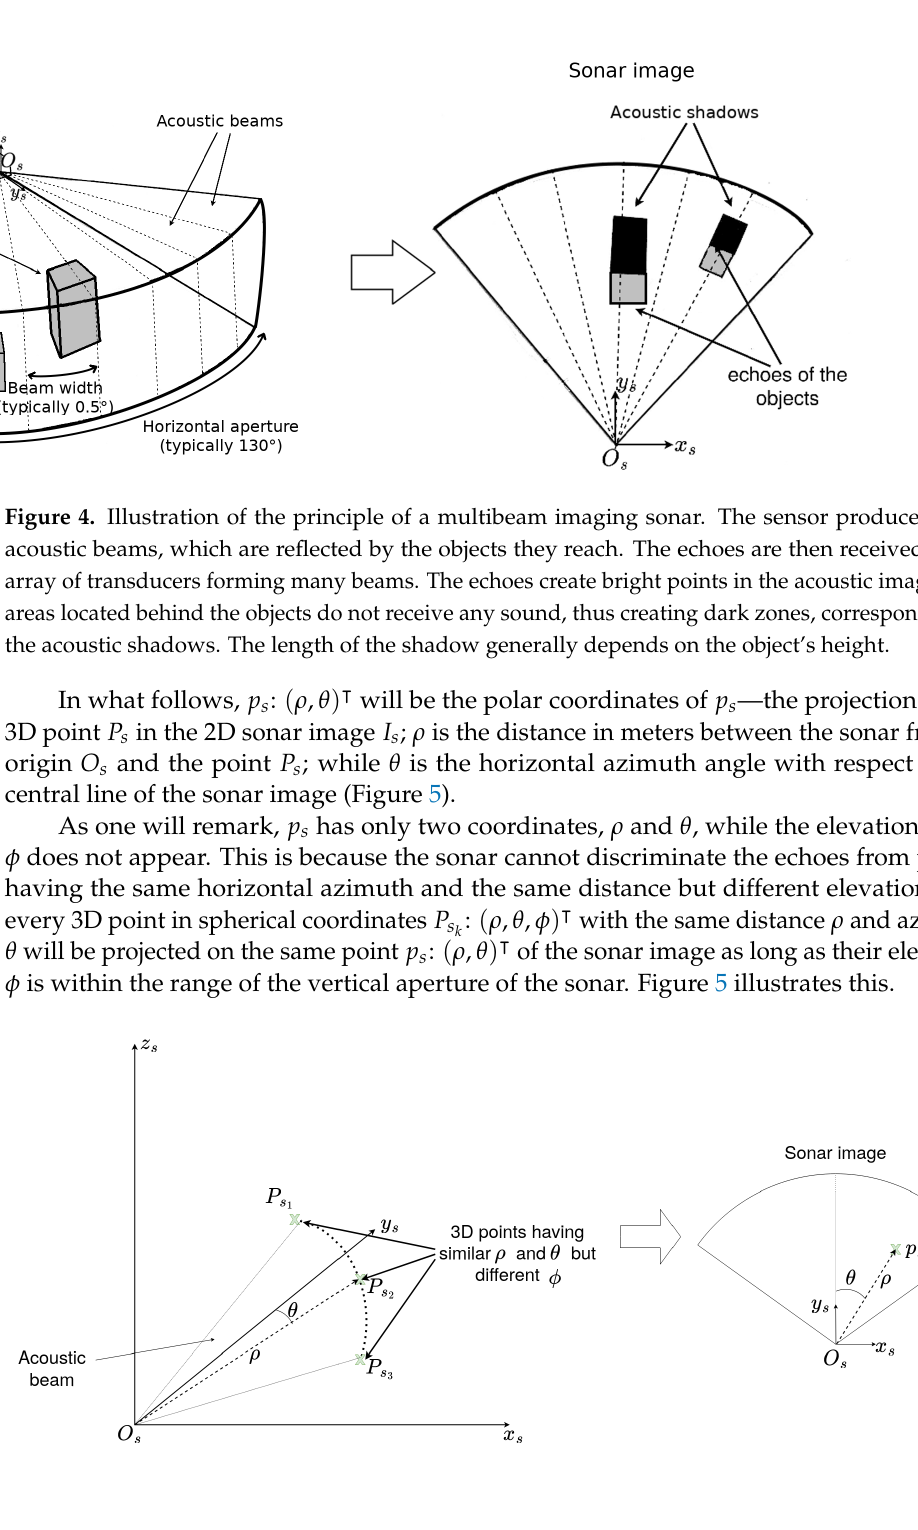
Figure 5. Illustration of the sonar elevation incertitude effect. In the figure, we can see that the three 3D points P s , P s , and P s —having the same azimuth angles θ and the same range ρ but different 2 3 1 elevation angles φ along the doted arc—will be projected on the same point p s in the sonar image (on the